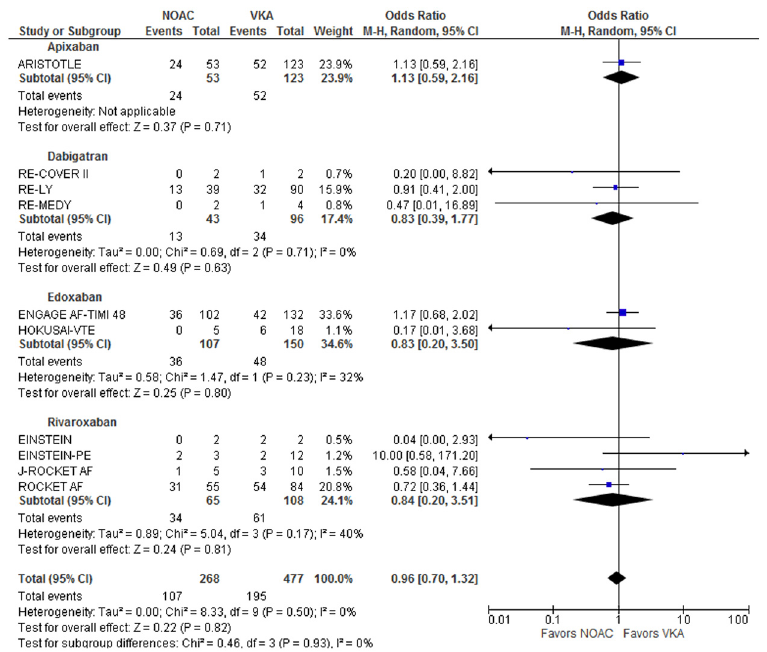
Fig 4. Relative odds of fatal bleeding given patient with intracranial bleeding event. Odds ratios and 95% confidence intervals are given for the relative odds that intracranial bleeding events will lead to fatal bleeding